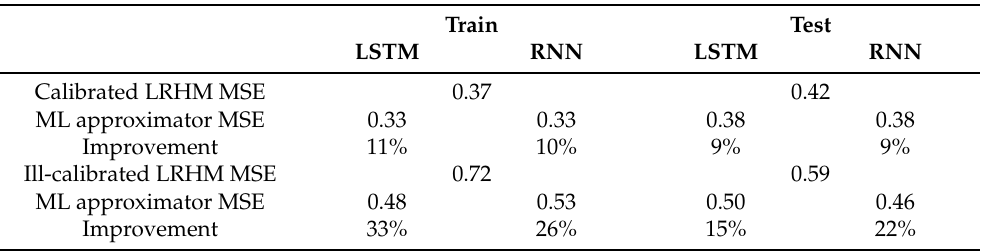
Figure 9. Assessment of the ill-calibrated hydrological model LRHM in Alagonia. LSTM ( a ) and RNN ( b ) employed to approximate the best model that can be obtained with the available data during the test period. Table 2. Percentage improvement of the performance of the ML approximator over the calibrated and ill-calibrated LRHM hydrological model in the Alagonia case